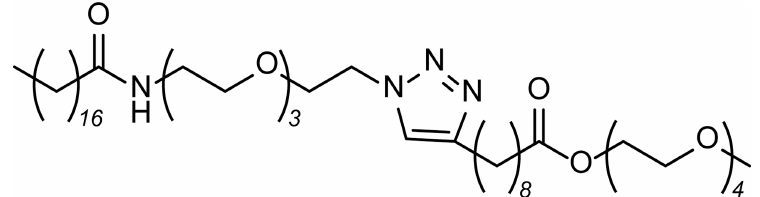
Fig 1. Scheme of alternating tetra-block-like amphiphile